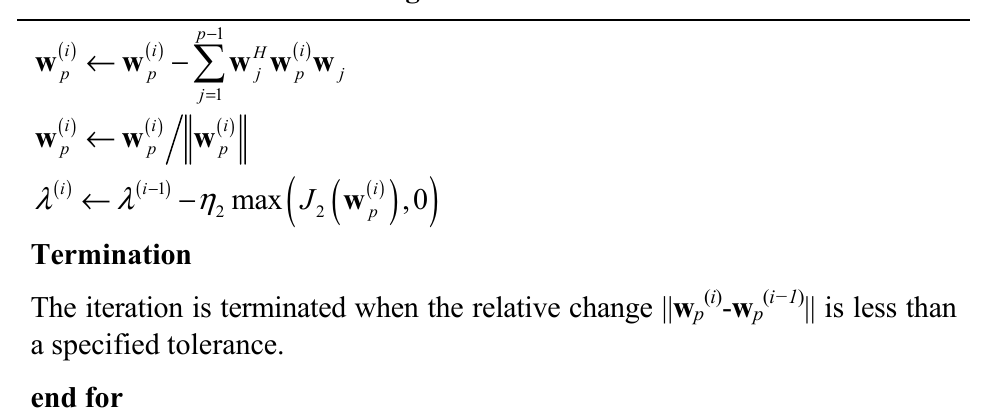
Algorithm 1. Cont.